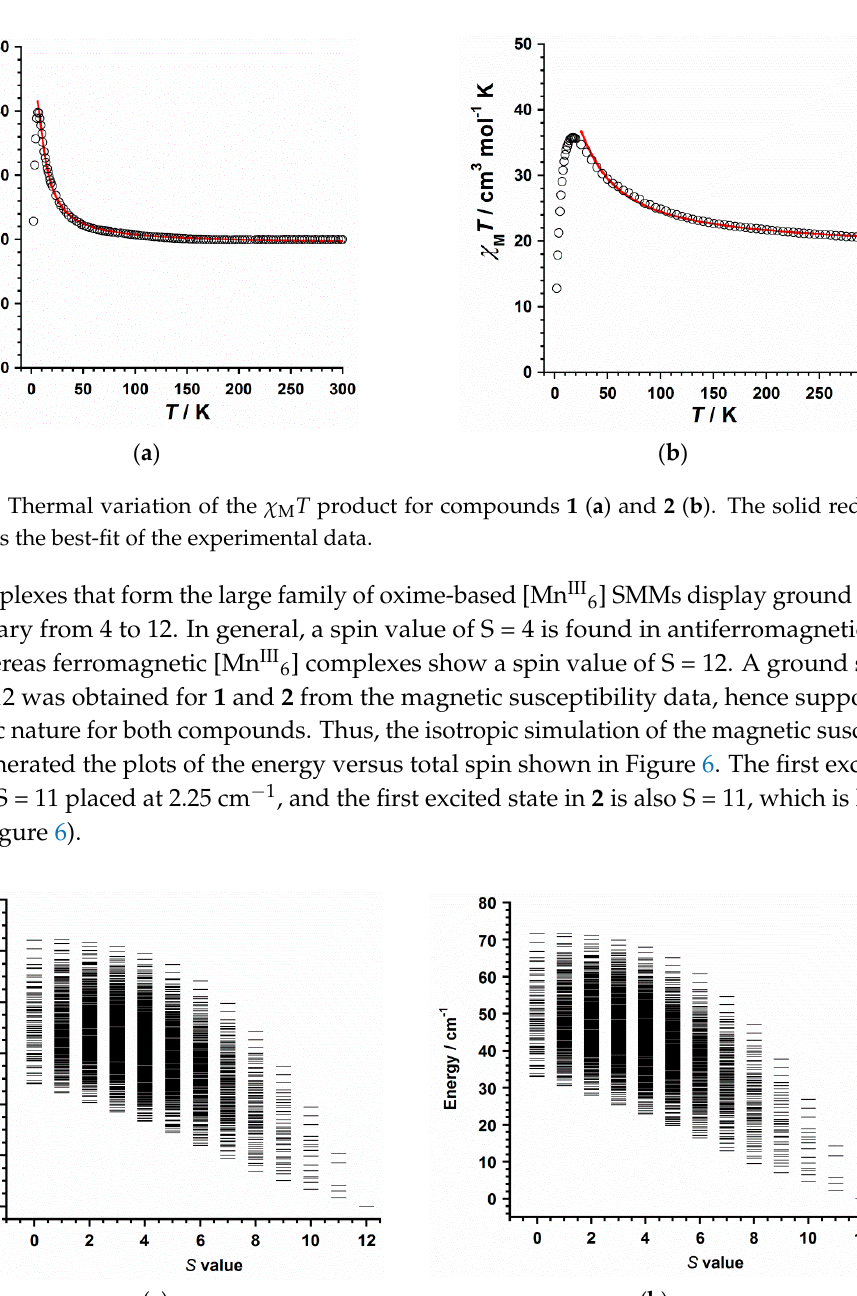
Figure 6. Plot of energy versus total spin state, extracted from the isotropic simulation of the susceptibility data for 1 ( a ) and 2 ( b ).